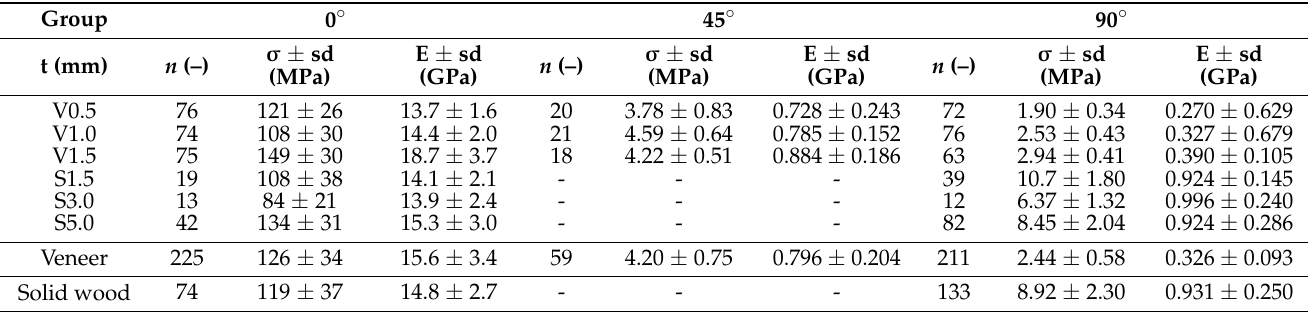
Table 2. Results of 495 veneer and 207 solid wood samples. (V = veneer, S = Solid wood, t = thickness category, n = number of samples tested, σ = strength in the corresponding direction, sd = standard deviation and E = modulus of elasticity in the corresponding